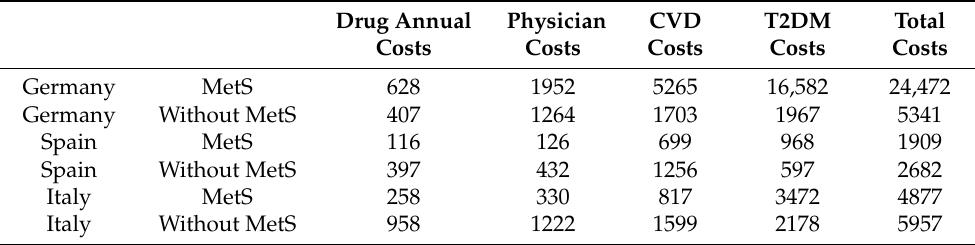
Table 3. Annual cost (in millions, € ) of hypertension and costs due to MetS (table content elaborated and modified from the original article by Scholze et al., 2010